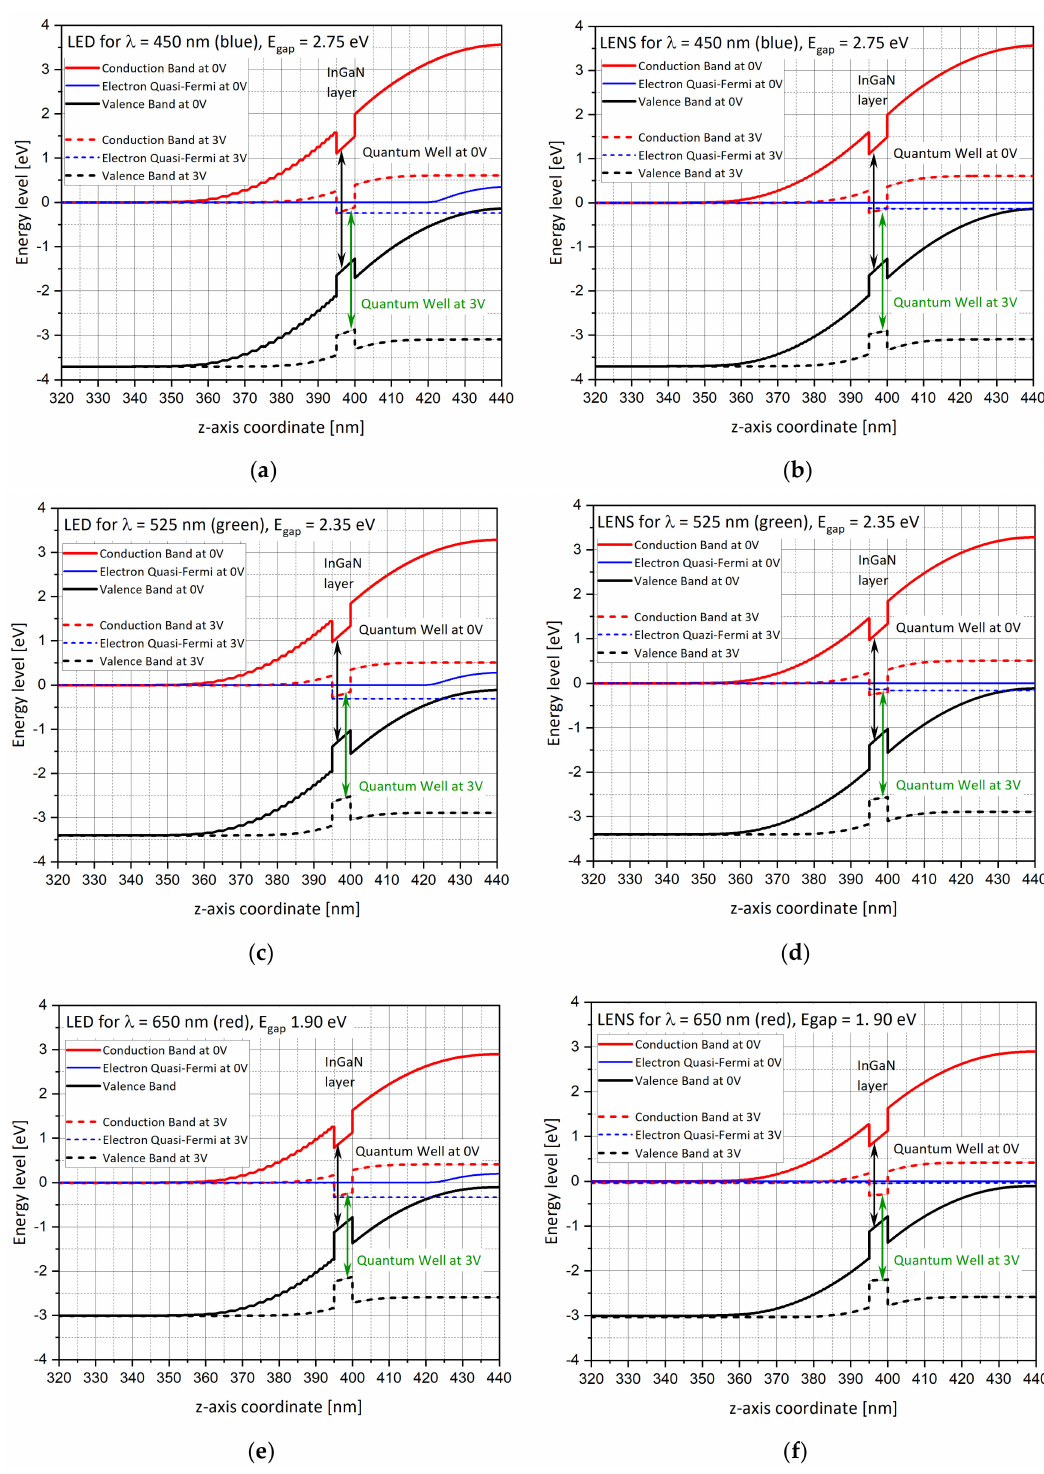
Figure 8. Energy diagrams as a function of the applied voltages, for V p = 0 V and for V p = 3 V, along the z axis (r = 0), and showing the PIN junction. ( a ) LED, λ = 450 nm; ( b ) LENS, λ = 450 nm; ( c ) LED, λ = 525 nm; ( d ) LENS, λ = 525 nm; ( e ) LED, λ = 650 nm; ( f ) LENS, λ = 650